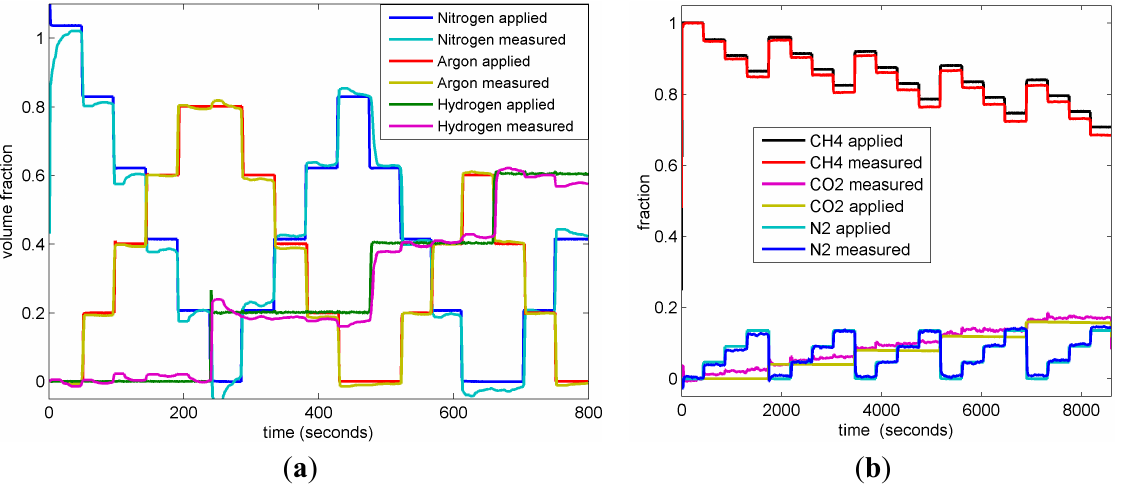
Figure 6. ( a ) Volume fraction of a hydrogen/air mixture based on the measured heat capacity. ( b ) Volume fraction of methane/carbon dioxide mixture.